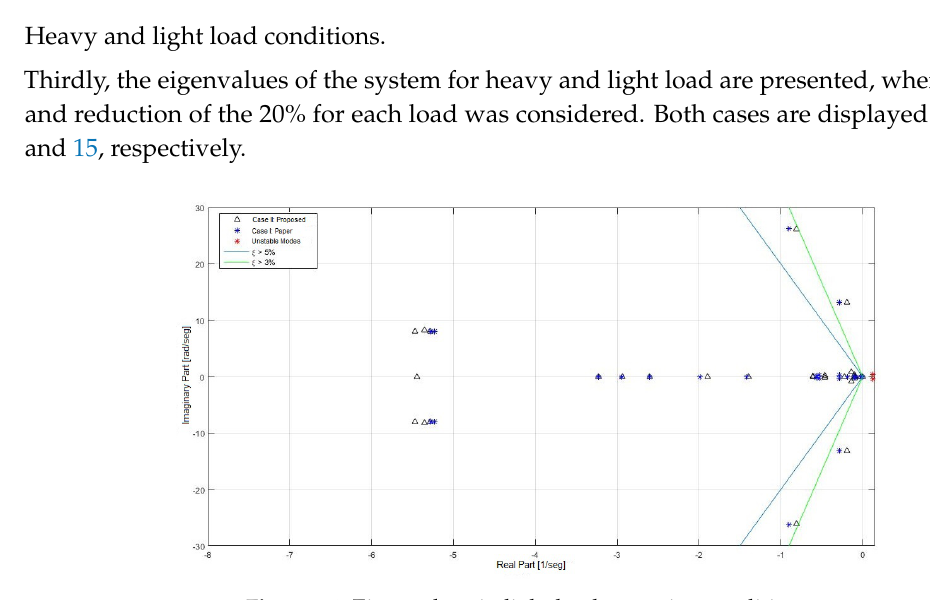
Figure 14. Eigenvalues in light load operation